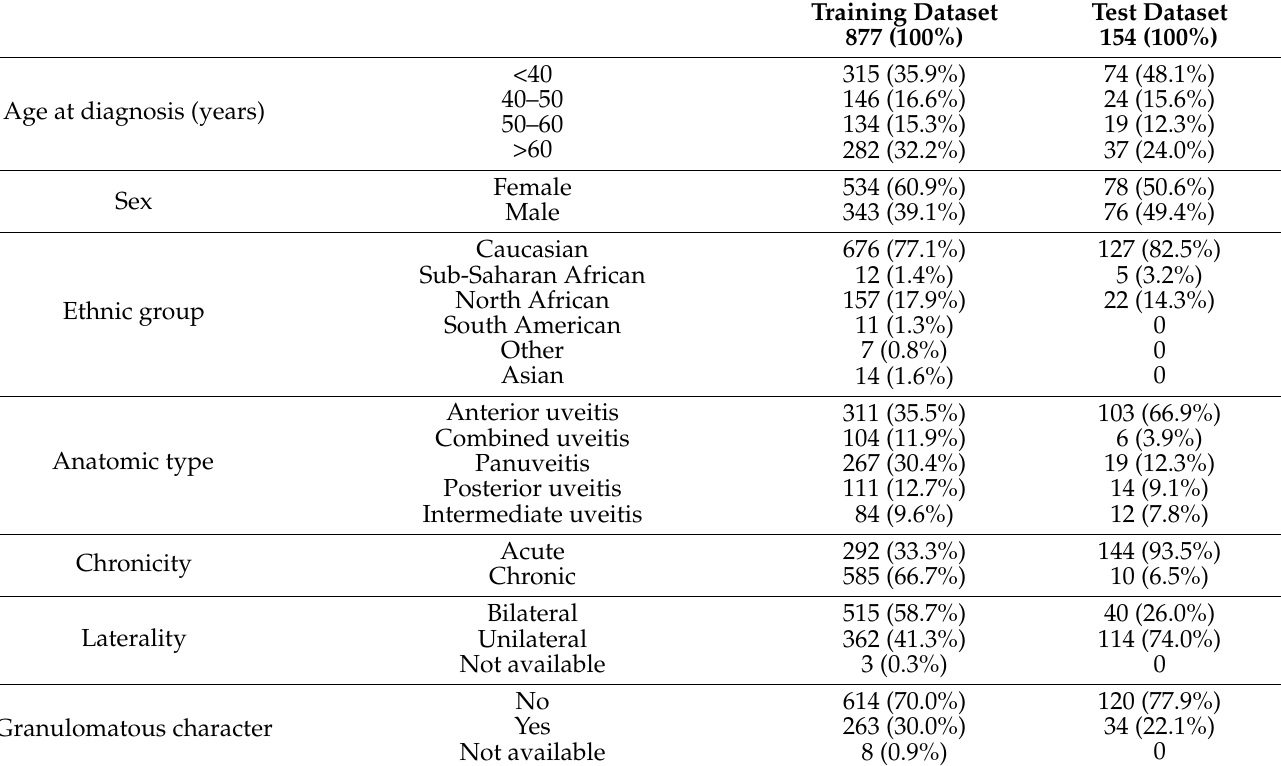
Table 1. Description of the characteristics of the patients in training dataset and in the test